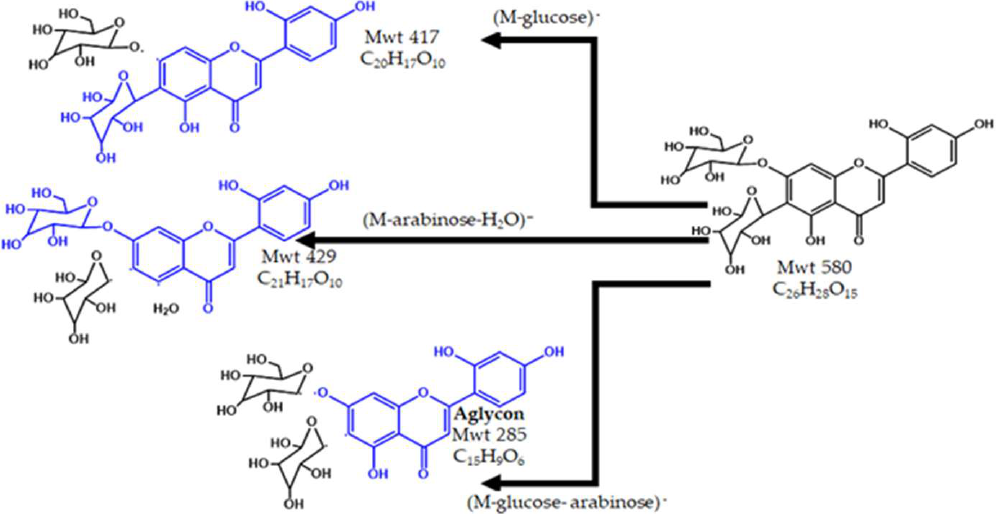
Figure 3. The structure and fragmentation of 2 (cid:48) ,4 (cid:48) –trihydroxy–flavone–8– C – α –arabinopyranoside –7– O – β